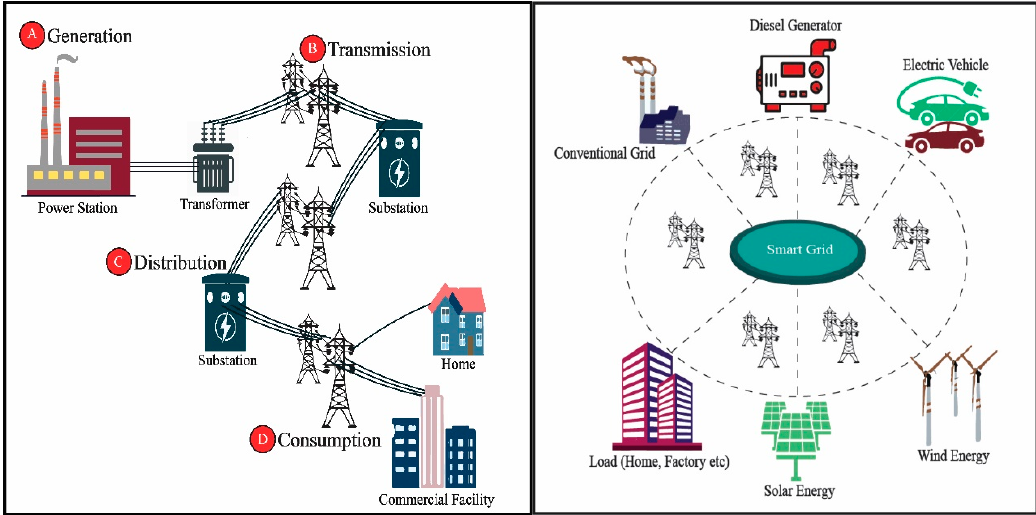
Figure 1. Conventional and smart grid infrastucture.